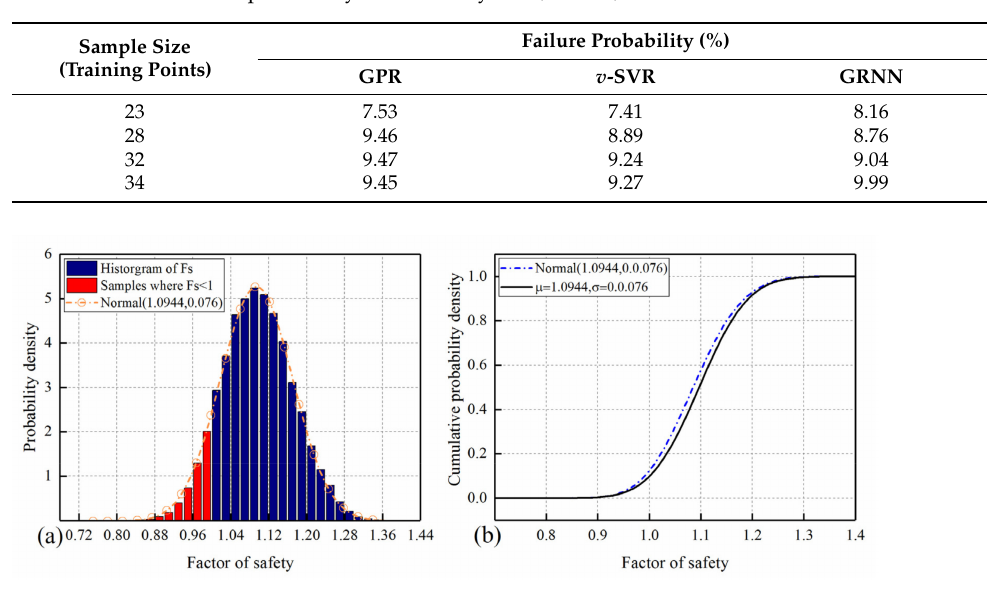
Table 10. Model failure probability estimated by GPR, v -SVR, and GRNN methods in Case 2.